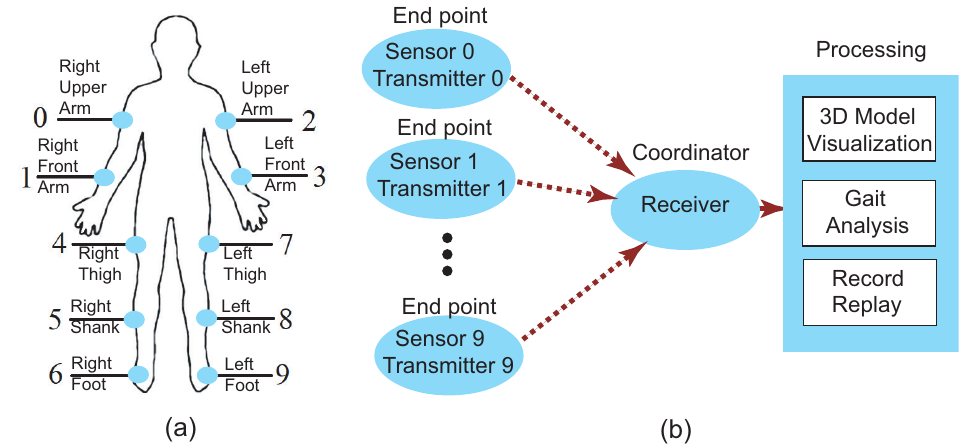
Figure 3. The sensor deployment ( a ) and the star network configuration of the fully wireless motion sensing system ( b